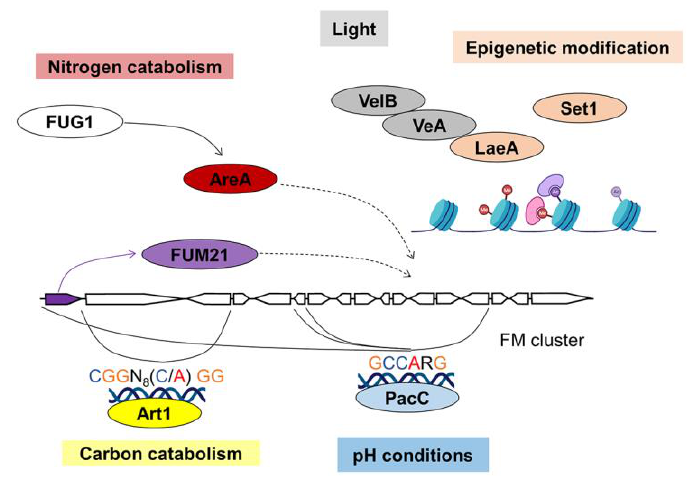
Figure 6. Regulatory mechanism of FM biosynthesis.